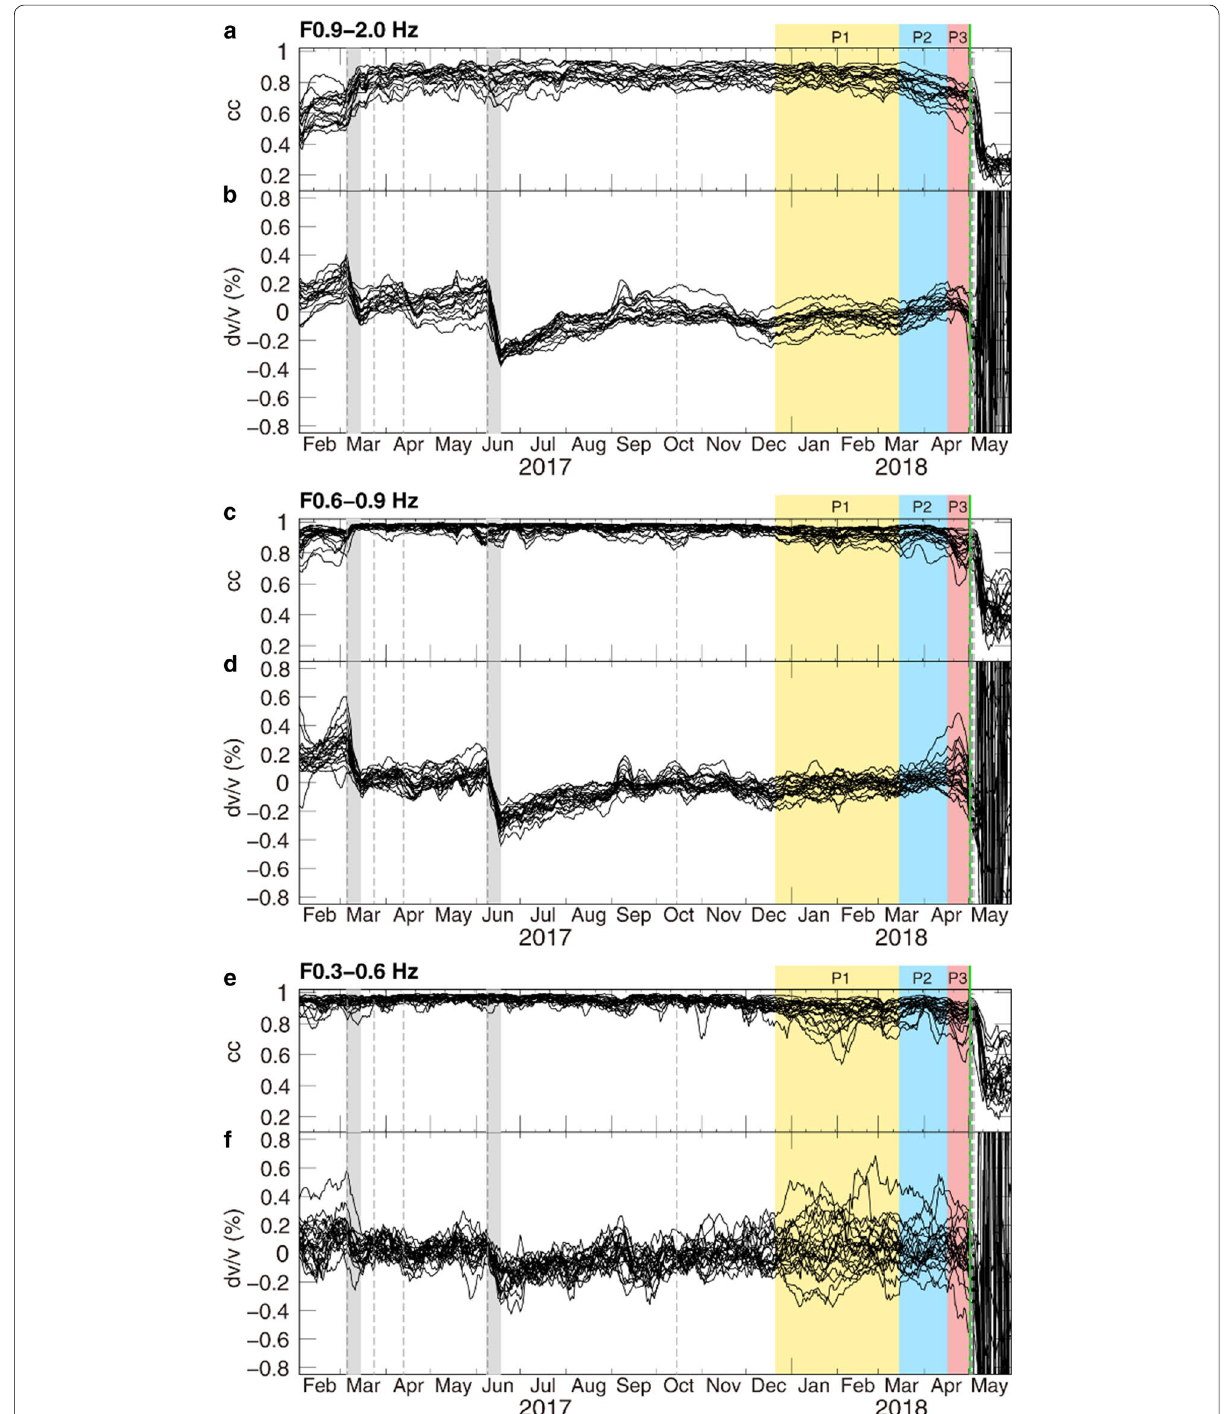
Fig. 6 Time series of cc values and estimated d v / v in three frequency bands. a , b 0.9–2.0 Hz. c , d 0.6–0.9 Hz. e , f 0.3–0.6 Hz. Grayish shaded zones mark 10 days following the occurrence time of earthquake No. 1–3 and No. 6. Yellowish shaded zone represents Period 1 (P1, from December 20, 2017 to March 15, 2018). Bluish shaded zone represents Period 2 (P2, from March 15, 2018 to April 17, 2018). Reddish shaded zone represents Period 3 (P3, from April 17, 2018 to May 1, 2018). Dashed lines mark the occurrence times of earthquakes shown in Fig. 1. Green lines after P3 mark the